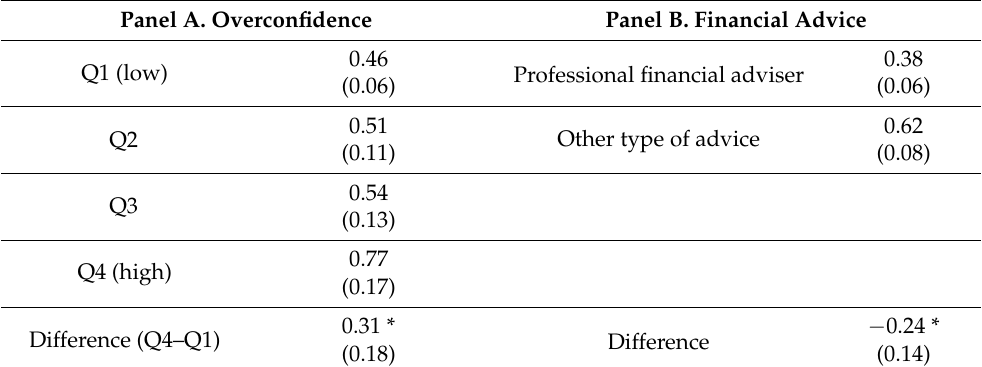
Table 2. Return Loss, Univariate